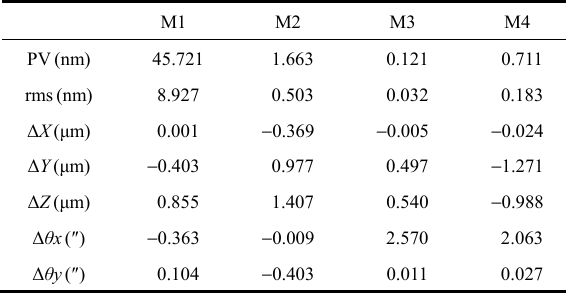
Fig. 7 Surface fitting nephogram of reflective mirrors, the order from left to right is M1, M2, M3, and M4. Table 2 Change of surface shape and position of each mirror.